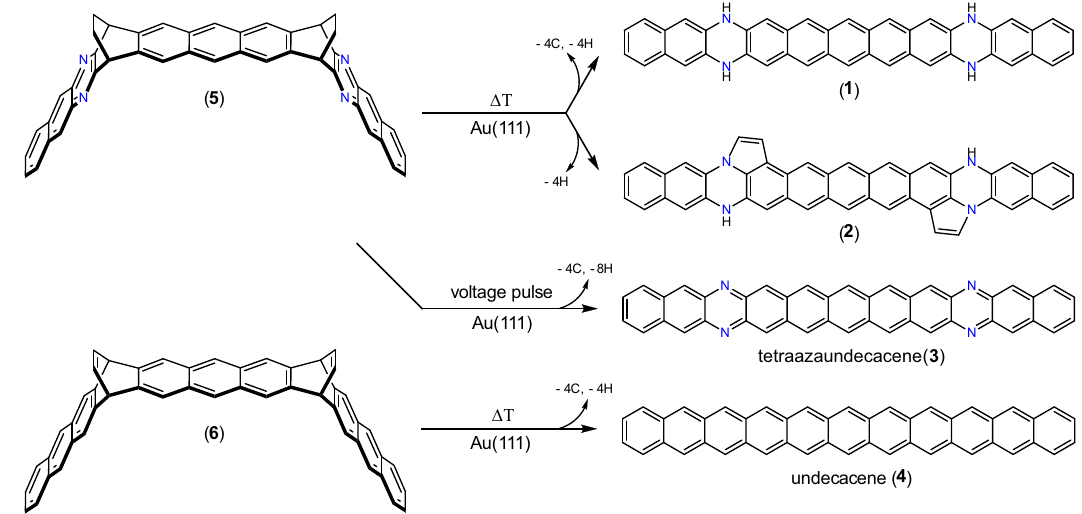
Fig. 1 On-surface synthetic strategy. Schematic representation of the synthesis of N,N ′ ,N ″ ,N ‴ -tetrahydro-6,12,19,25-tetraazaundecacene 1 , its analog with two edge-fused fi ve-membered rings 2 , 6,12,19,25-tetraazaundecacene 3 , and the pristine undecacene 4 from the corresponding speci fi cally designed precursors 5 and 6